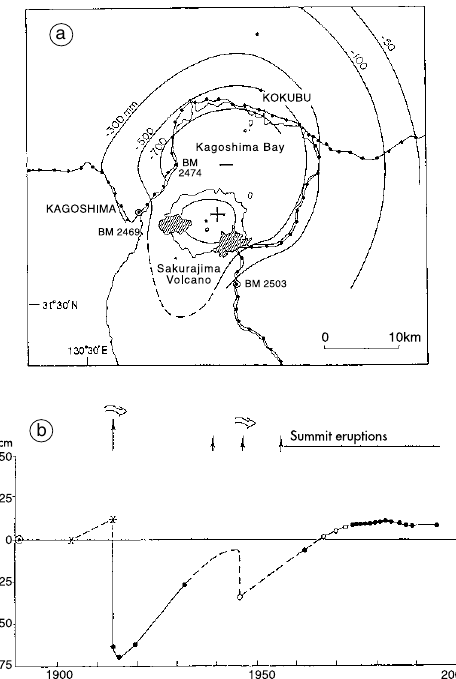
Fig. 10a,b. Aira caldera. a) The subsidence (mm) caused by the 1914 eruption of Sakurajima volcano, the hatched parts indicate the new lava flows (after Omori, 1914-1922). b) Secular deformation of BM 2474 referred to BM 2469. The asterisks show the interpolation (data after Sakurajima Volcano